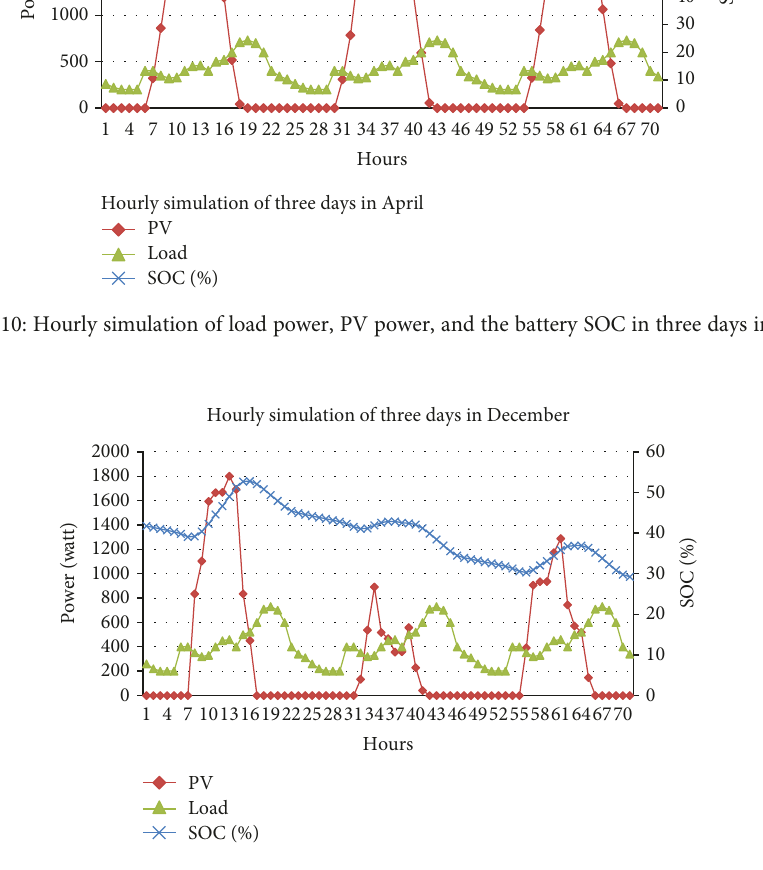
Figure 11: Hourly simulation of load power, PV power, and the battery SOC in three days in